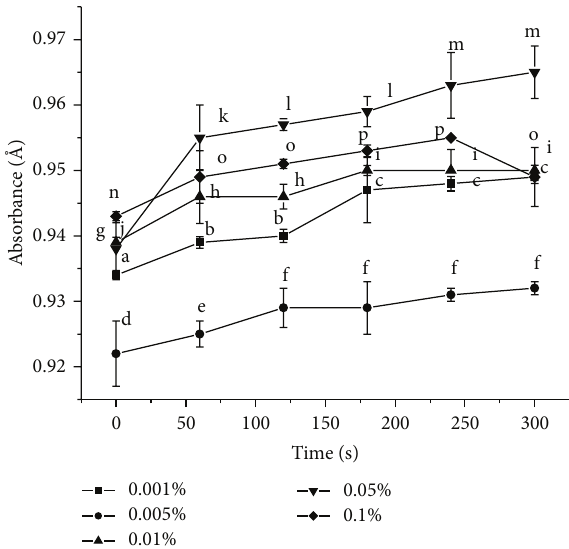
𝛼 - and 𝛽 -carotene crystals at different concentrations. Values are Mean ± SEM of 3 observations. At the 0.05 level, at time intervals 0, 60, 120, 180, 240, and 300 seconds, the difference in superscripts indicates significant difference in means. Superscripts (1) (a, b, c) for 0.001%; (2) (d, e, f) for 0.005%; (3) (g, h, i) for 0.01%; (4) (j, k, l, m) for 0.05%; and (5) (n, o, p) for 0.1% are